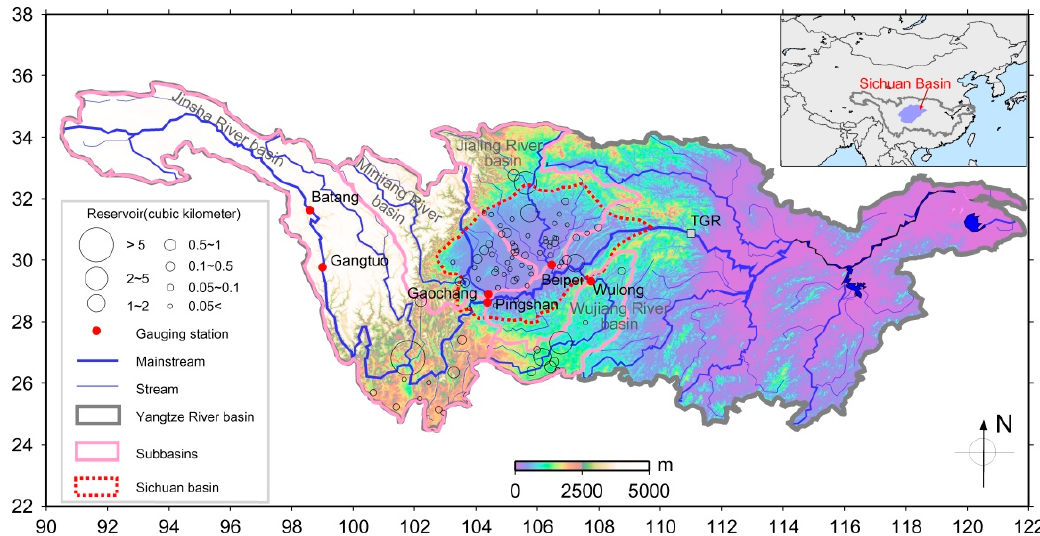
Figure 1. Yangtze River basin and its main sub-basins in the upper reach. The circle represents the location and capacity of reservoirs.